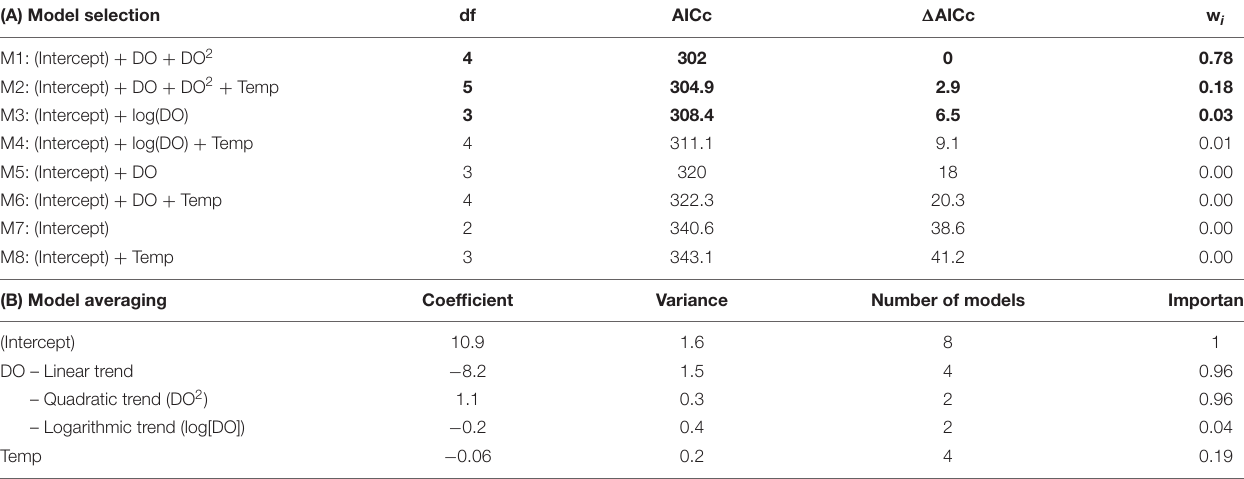
FIGURE 4 | Hypoxia-driven ASR tendency of Poecilia sulphuraria for a morning (A) and midday temperature scenario (B) . Time spent at the water surface performing ASR increased with decreasing oxygen concentrations at both test temperatures in a laboratory setting. Each data point equals the cumulative time spent at the surface for one group of 5 adult fish ( n = 27 groups). Darker points represent data collected at higher levels of aquatic oxygen. The half-maximal concentration at which fish spend 50% of their time at the surface (ASR 50 ) was estimated at 1.68 mg/L DO for 28 ◦ C and 1.74 mg/L DO for 26.5 ◦ C (M2-estimated trend lines in black). TABLE 2 | Overview of GLMMs tested to predict surface time of Poecilia sulphuraria